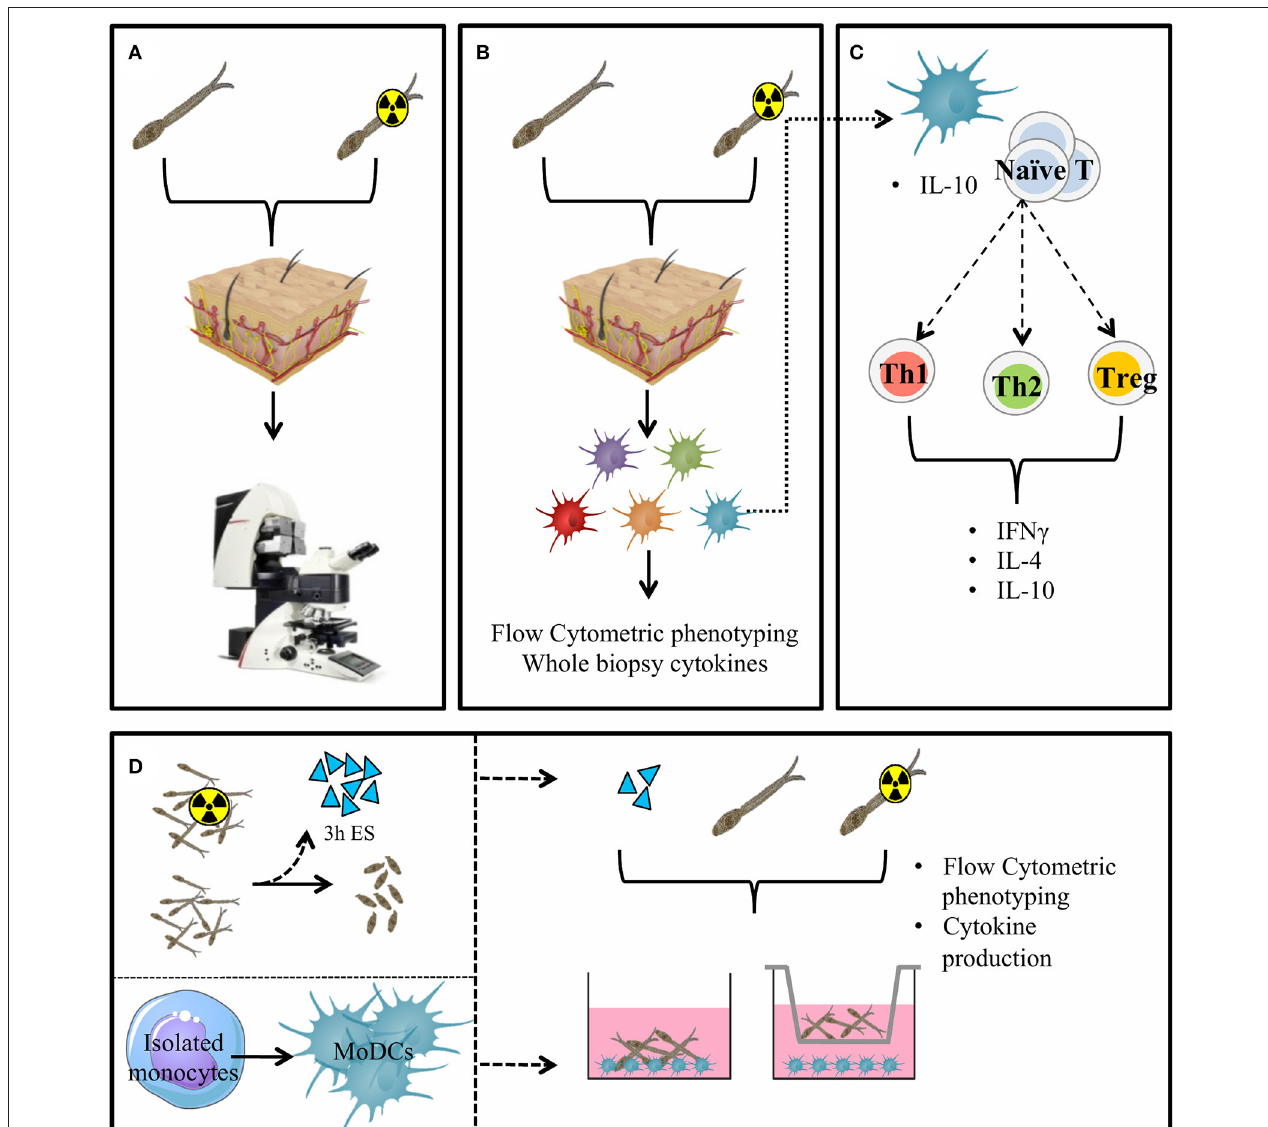
FIGURE 1 | General presentation of the skin invasion set up and immunological markers studied. Skin invasion imaging setup: S. mansoni (RA) cercariae are irradiated or kept at RT. Human skin explant pieces are mounted on confocal microscopy dishes and cercariae are added to the epidermal side. Explants are imaged with a confocal microscope. (A) Skin explants are exposed to (RA) cercariae in water and cultured to harvest emigrating DDCs (B) . DDCs are co-cultured with naïve T cells to assess functional effects (C) . Monocyte derived dendritic cells (D) (MoDCs) are differentiated from human monocytes. Three hour ES products are generated from (RA) schistosomula. Stimulation of MoDCs with (RA) cercariae or their ES products in presence or absence of a